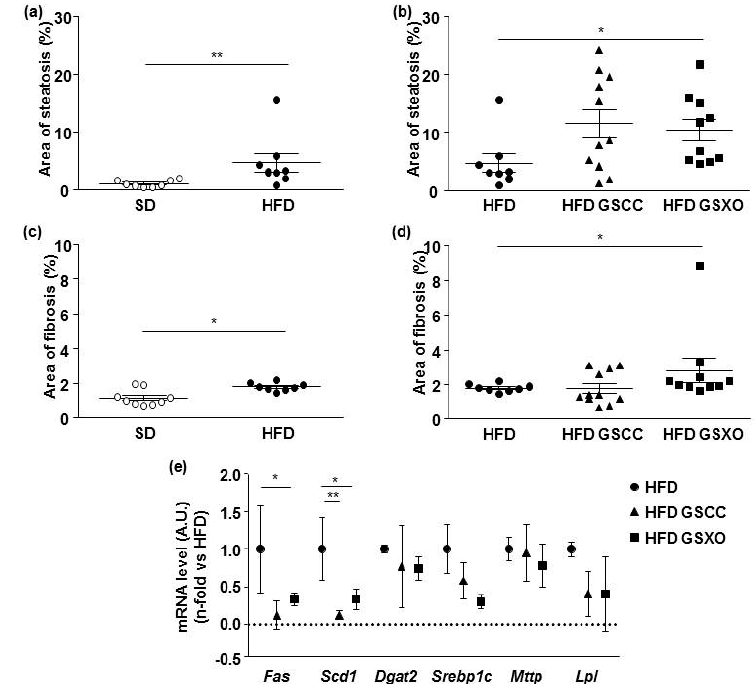
Figure 3. Effect of diet and apple supplementation on liver of ApoE-/- mice. Steatosis ( a , b ) and fibrosis ( c , d ) area in mice receiving standard diet (SD, with circle), high fat diet (HFD, black circle), and HFD supplemented with apple for 14 weeks (black square and black triangle for HFD supplemented with GSCC and GSXO, respectively). ( e ) Hepatic relative expression of mRNA levels of several genes involved in lipogenesis: fatty acid synthase ( Fas ), stearoyl-coenzyme A desaturase-1 ( Scd1 ); diacylglycerol O-acyltransferase 2 ( Dgat2 ); sterol regulatory element-binding transcription factor 1 ( Srebp1c ); microsomal TG transfer protein ( Mttp ); lipoprotein lipase ( Lpl ). The data were expressed as the mean ± SEM. * p < 0.05, ** p < 0.01.